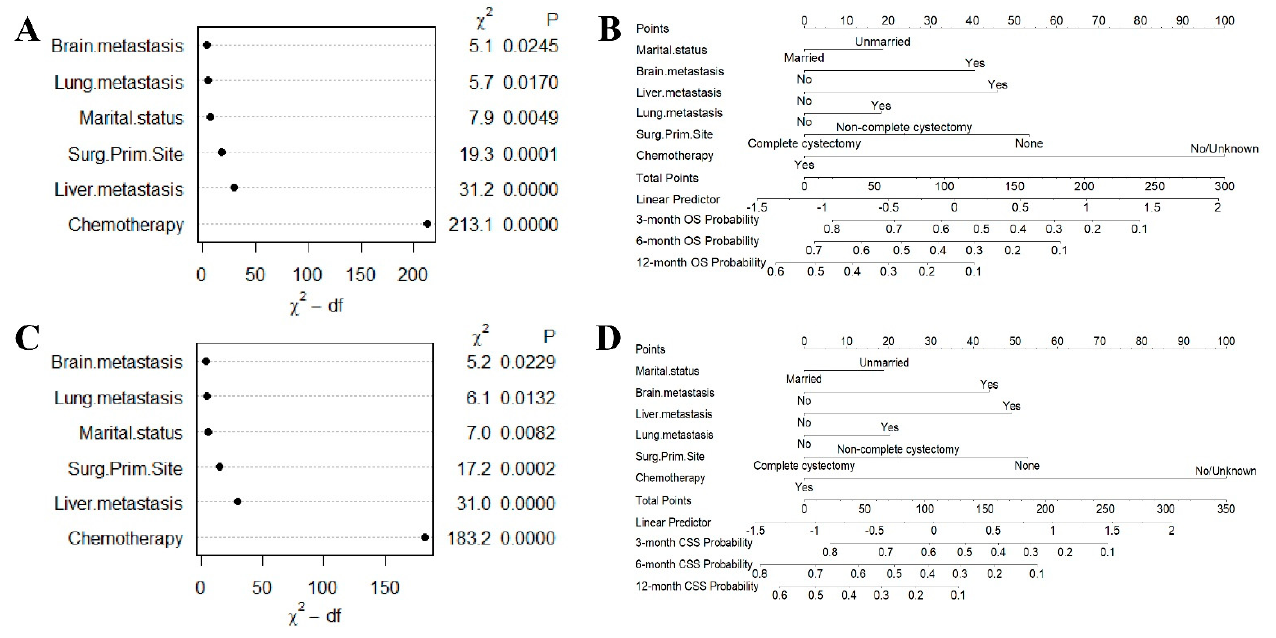
Figure 2. Variable importance and nomograms of ( A , B ) overall survival (OS) and ( C , D ) cancer-specific survival (CSS).